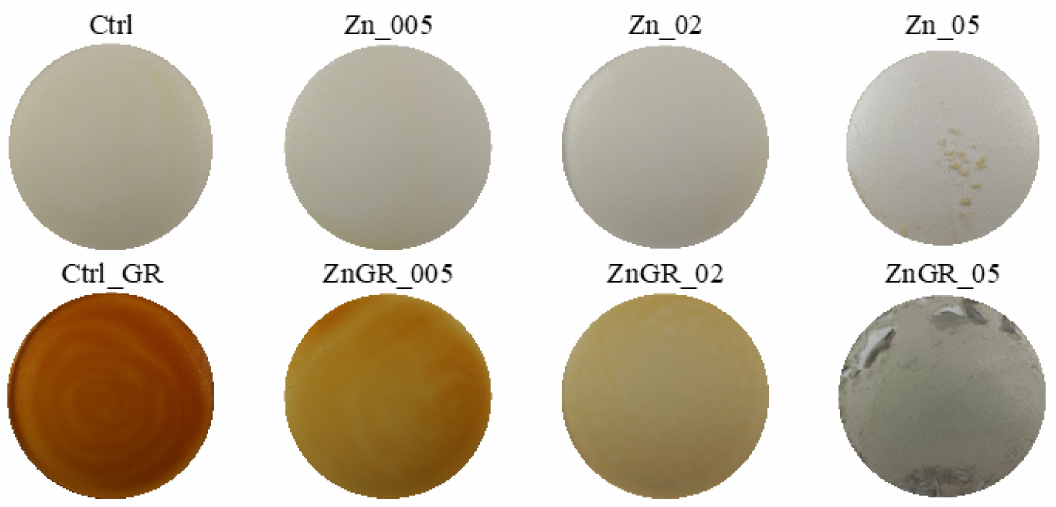
Figure 5. Digital images of edible coatings used for color analysis—samples with the addition of ZnO